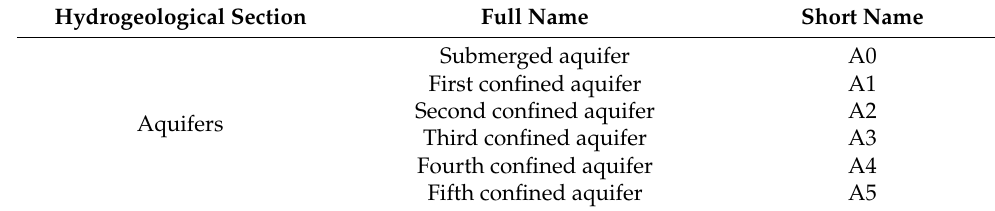
Table 1. The List of Hydrogeological Section.